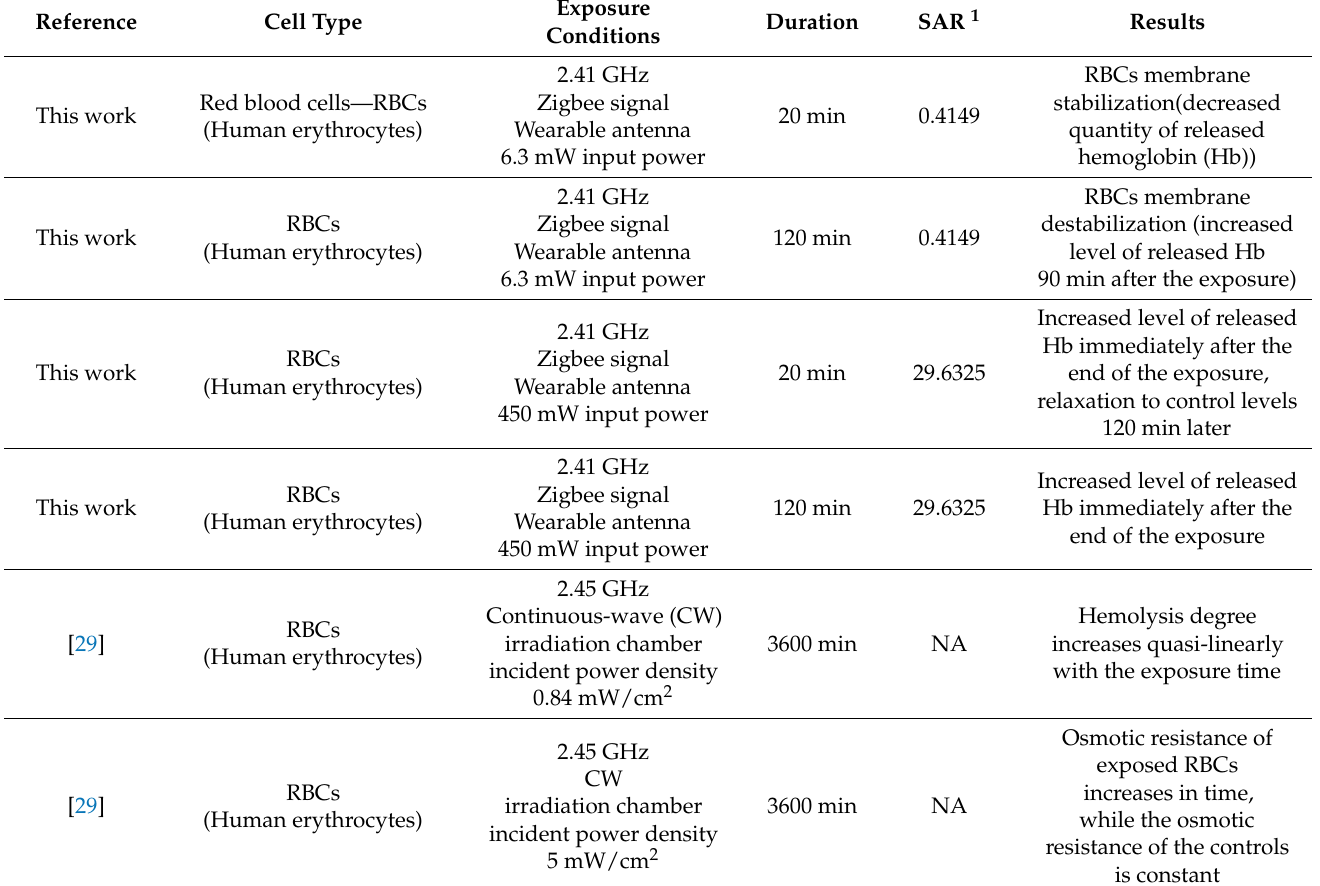
Table 5. Comparison of in vitro studies on biological effects from